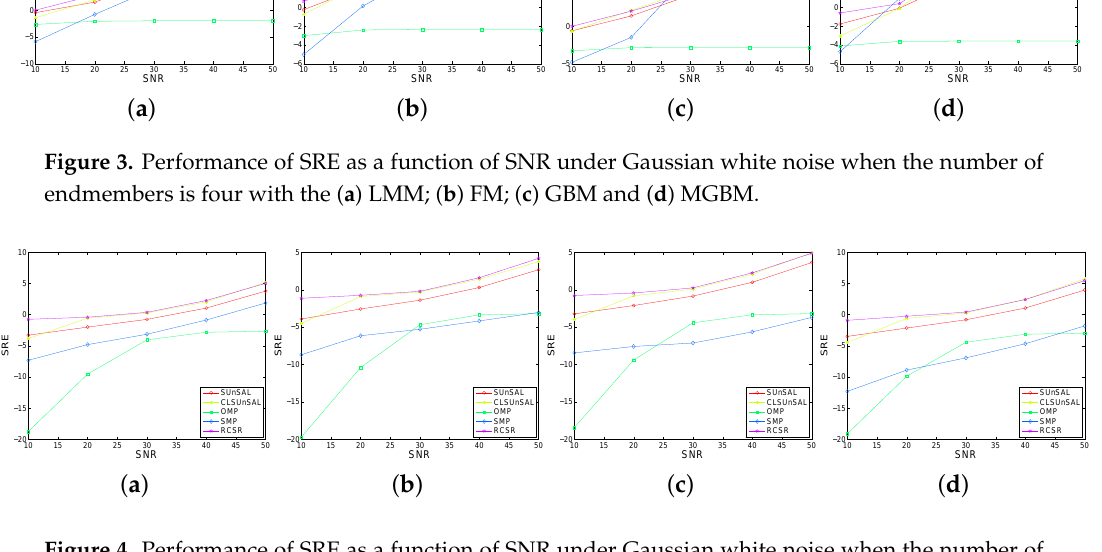
Figure 4. Performance of SRE as a function of SNR under Gaussian white noise when the number of endmembers is 20 with the ( a ) LMM; ( b ) FM; ( c ) GBM and ( d )